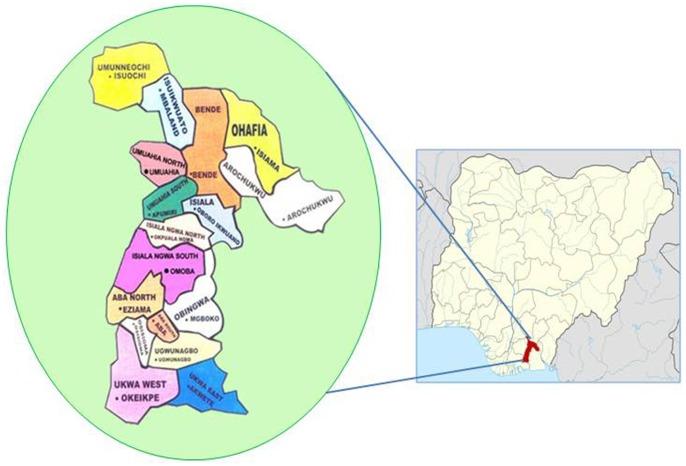
Geographical location of Abia State in Nigeria showing the distribution of local government areas within the state.